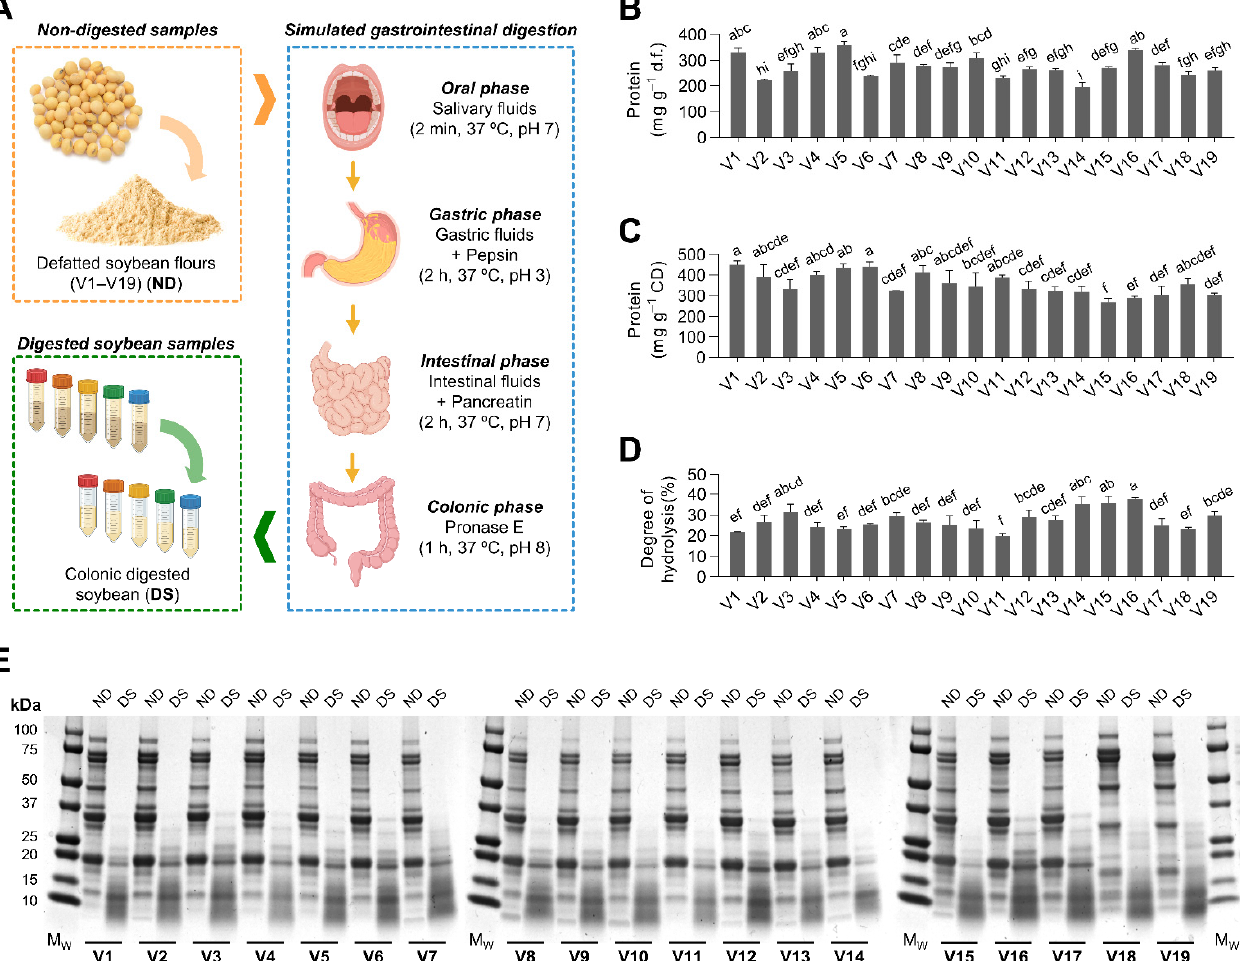
Figure 1. Illustrative diagram of the simulated digestion process followed to hydrolyze the different soybean varieties flours (V1 to V19) ( A ). Protein concentration (mg g − 1 ) in defatted soybean flours (d.f.) ( B ) and colonic digested soybeans (DS) ( C ). Degree of hydrolysis of the digested soybean flours ( D ) and representative SDS-PAGE electrophoresis gels ( E ) of the proteins from non-digested (ND) defatted soybean flours and their colonic digested soybeans (DS). Results are reported as mean ± SD ( n = 3). Bars with different letters significantly differ according to ANOVA and Tukey’s multiple range test ( p <